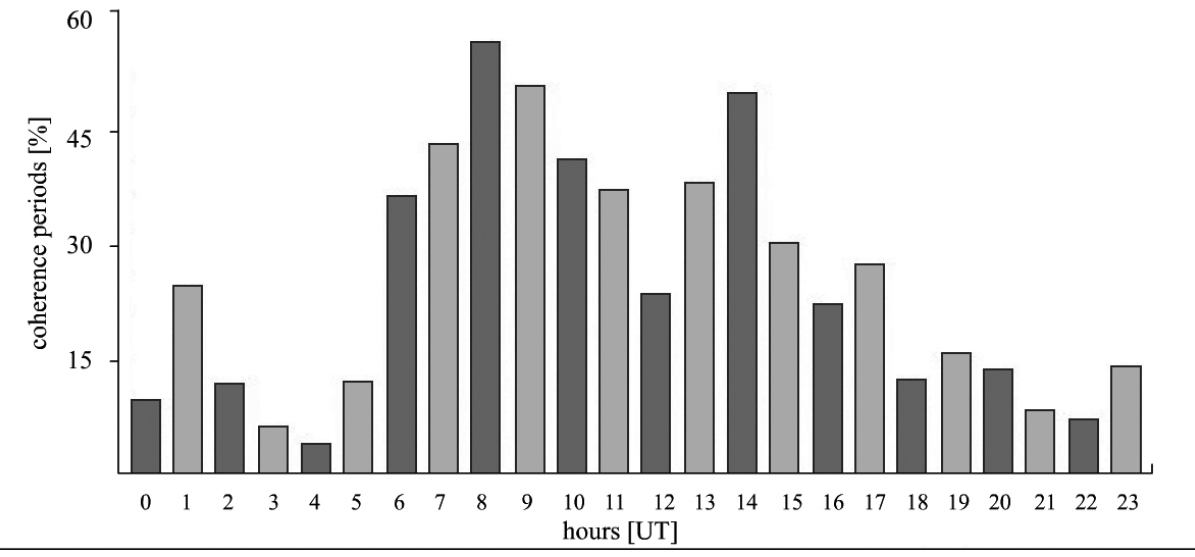
Figure 12. Percentage of occurrence of coherence for periods of 190-210 s calculated with the threshold values T